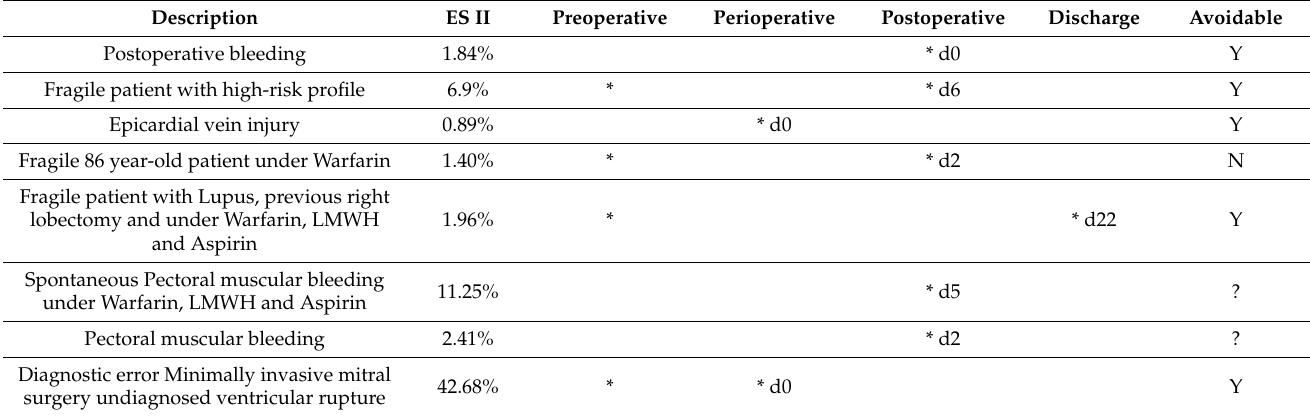
Table 2. Reoperation due to postoperative bleeding. ES II: EuroSCORE II *: adverse event (s),